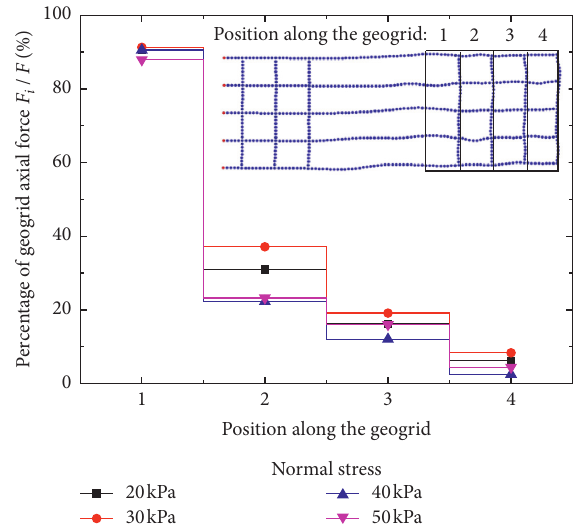
Figure 7: Percentage of axial force of BG1 against position along the geogrid.